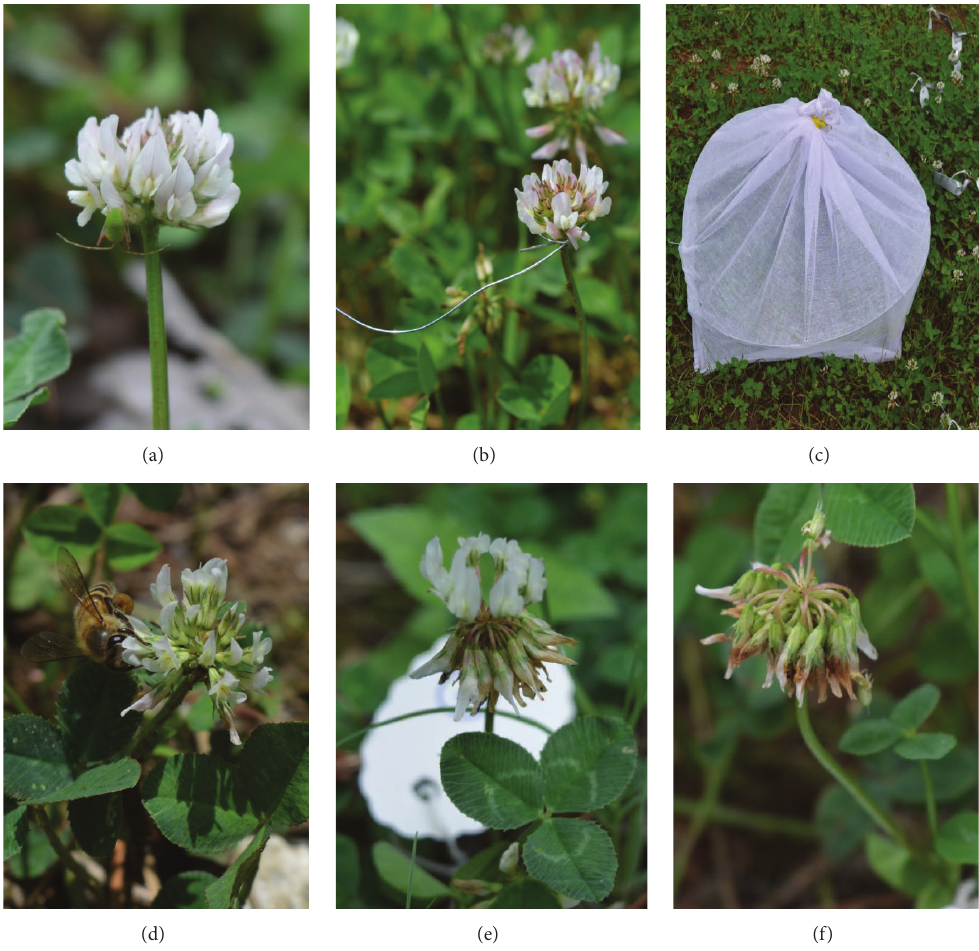
Figure 1: Inflorescence of Trifolium repens ((a) compact inflorescence with flower pointing upwards, (b) a constrained flower, (c) plants covered with net to deter pollination, (d) a pollinator on the peripheral mature flower, (e) half of the flowers have recurved while the ones yet to be fertilized face upwards, and (f) inflorescence completely recurved with fruit formation in the process).